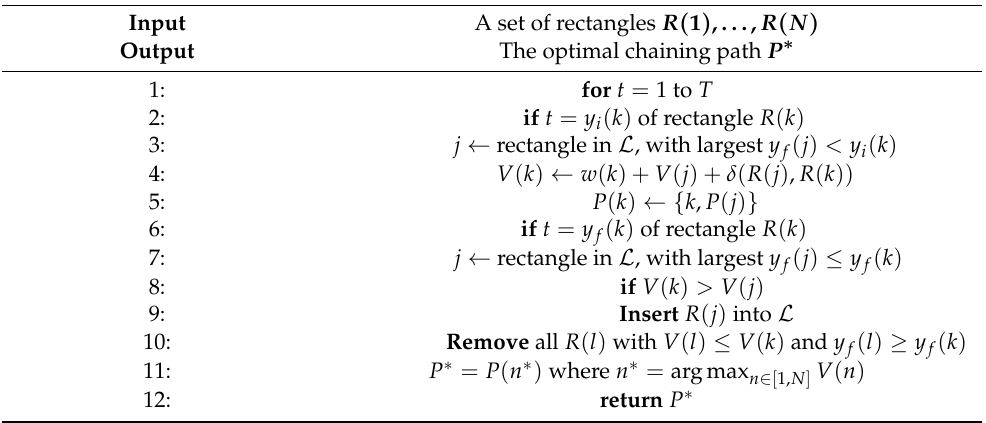
Algorithm 1 Proposed rectangle chaining